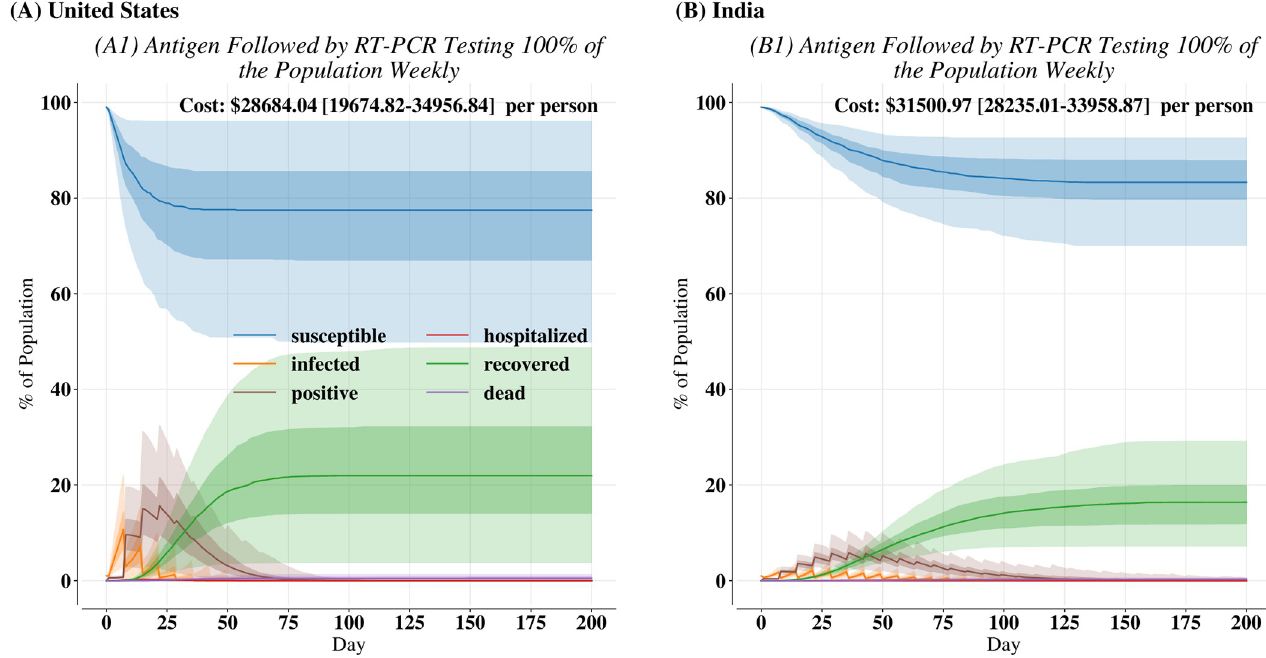
Fig 3. Disease course in (A) United States and (B) India for antigen testing followed by RT-PCR testing of antigen-negative individuals 100% of the population weekly. Bold lines are the median over 200 independent replicates. Dark-shaded regions are the 25 th to 75 th percentiles over the 200 independent replicates while light-shaded regions are 2.5 th to 97.5 th